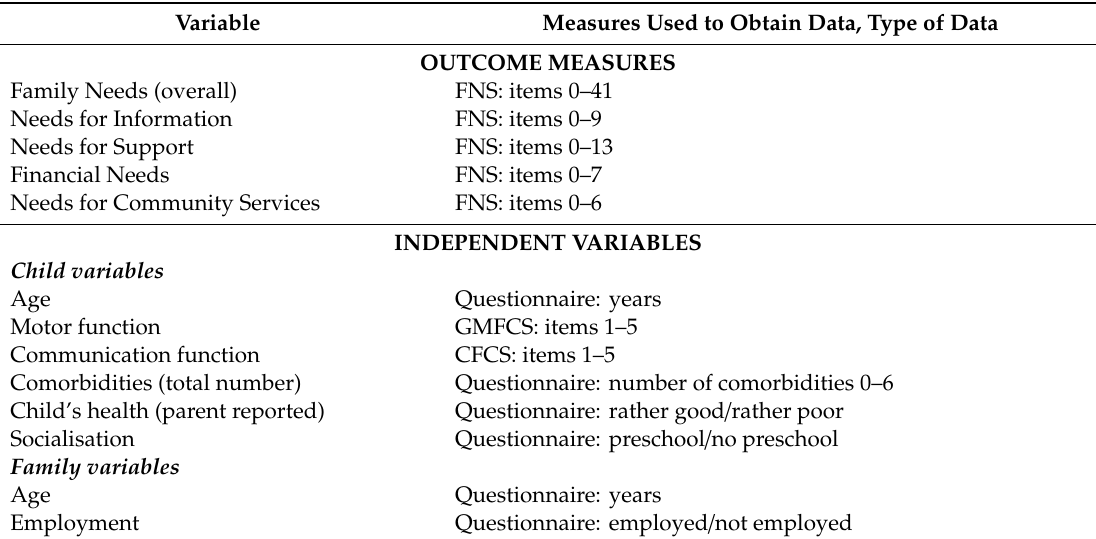
Table 3. Data used in study analysis and their